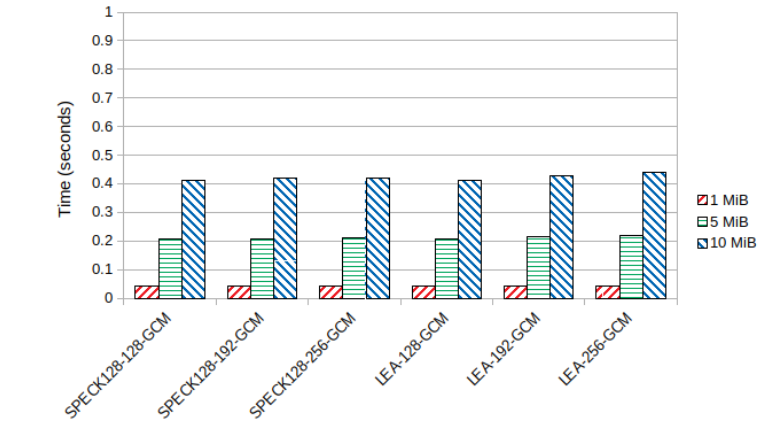
Figure A3. Average decryption time (seconds) in the ARMv7-a Samsung device.